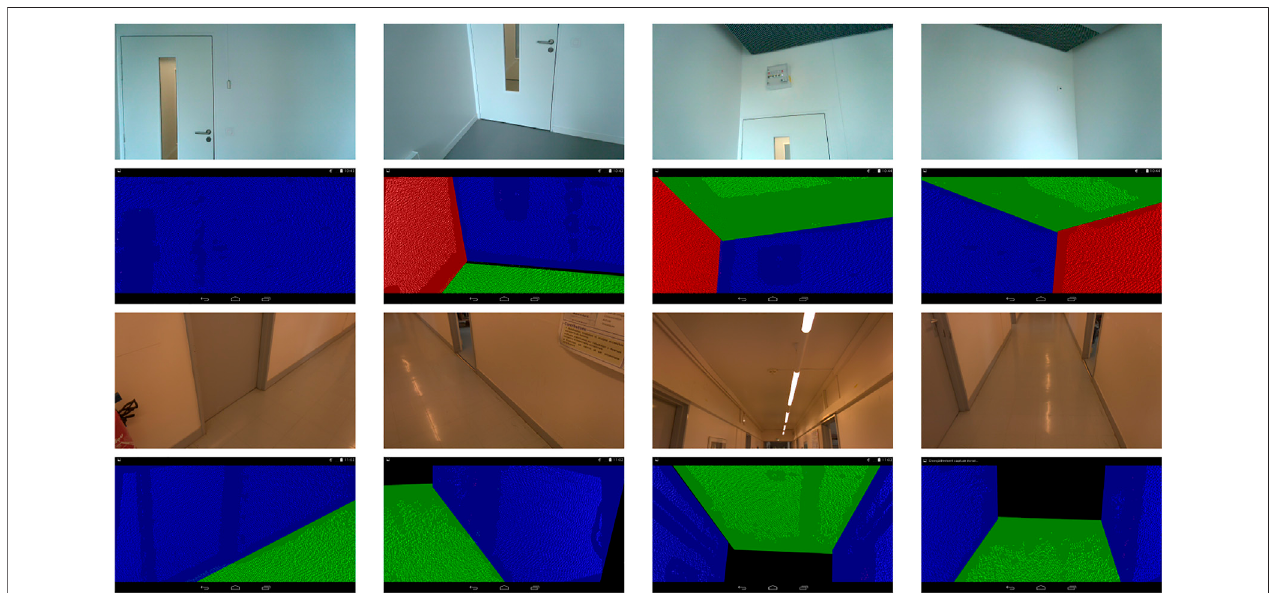
FIGURE 5 | Examples of walls identi fi cation. The ground and ceiling are displayed in green color, walls are drawn in blue and red.